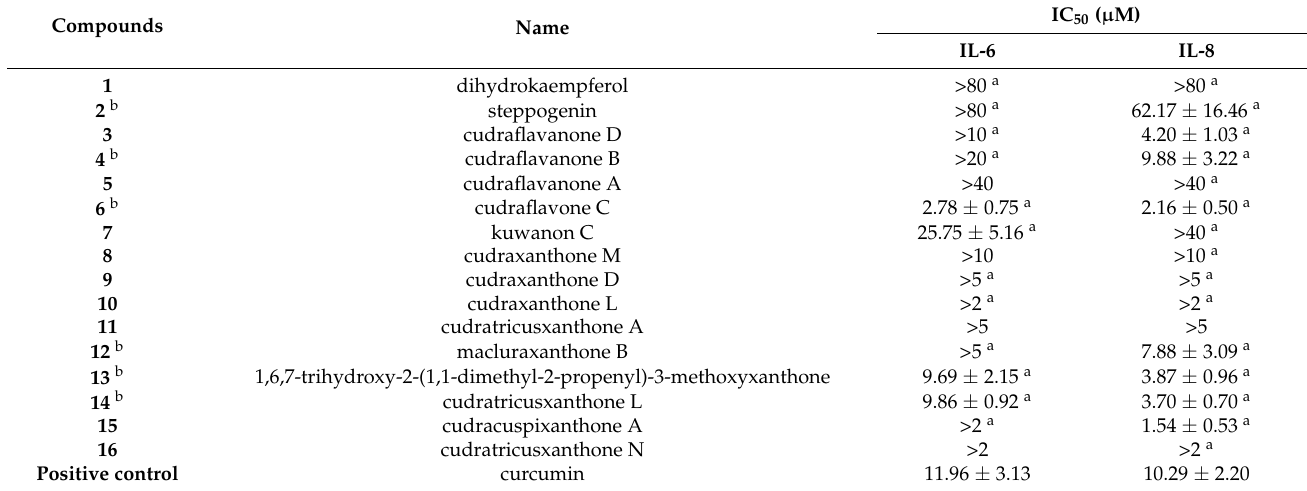
Table 3. Inhibitory effects of the 16 compounds on IL-6 and IL-8 production in TNF- α + IFN- γ -treated HaCaT cells.